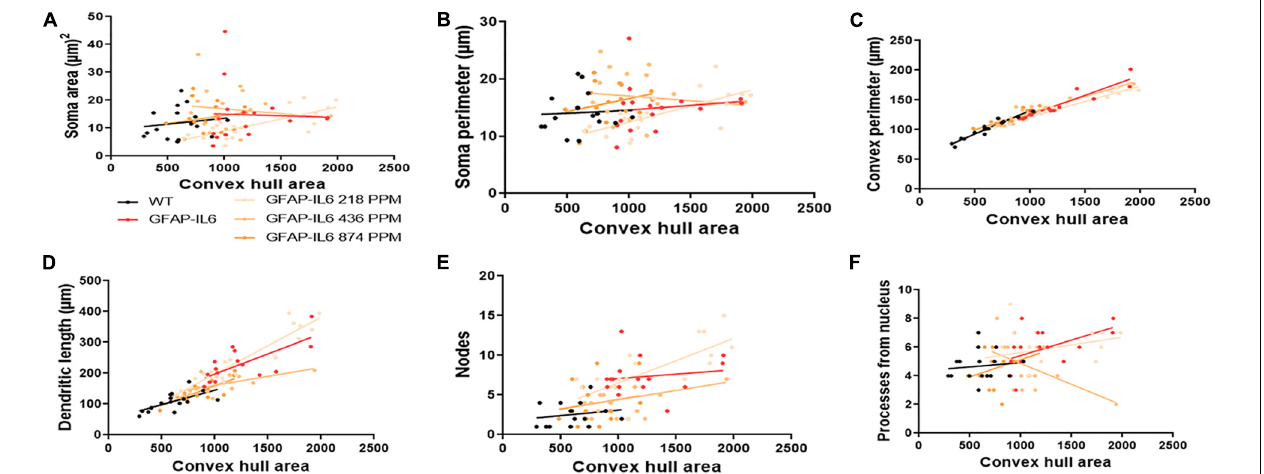
FIGURE 16 | Bivariate correlation: MC effects on astrocytes morphology are dose independent in the hippocampus. (A–F) Different morphological parameters have been plotted against convex hull area to see the bivariate correlation between the WT, GFAP-IL6 and between nontreated and treated astrocytes. The analysis revealed that the convex perimeter and dendritic length are significantly correlated irrespective of the MC dose, whereas in the case of a low dose of MC, soma area, soma perimeter and nodes while the primary dendrites in medium dose, are significantly correlated relative to convex hull area. Analyzed by ANCOVA and sum-of-square